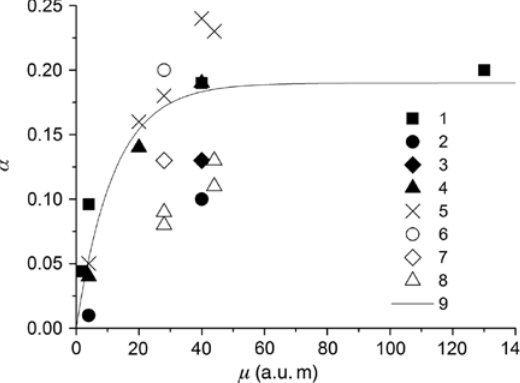
Figure 2: The measured values of the thermal accomodation coefficient in the conduction heat transfer of Fe and Mo NPs in dependence on molecular weight of bath gases. Closed symbols: data for the monoatomic gases. Open symbols: data for the polyatomic gases, (1) data by Elihn et al. and Landström et al. [85, 86], (2 and 6) data by Eremin et al. [87], (3 and 7) data by Kock et al. [26], (4 and 8) data by Sipkens et al. [43], (5) data for Mo NPs by Sipkens et al. [39], (9) best fit of monoatomic gas data by dumped exponential